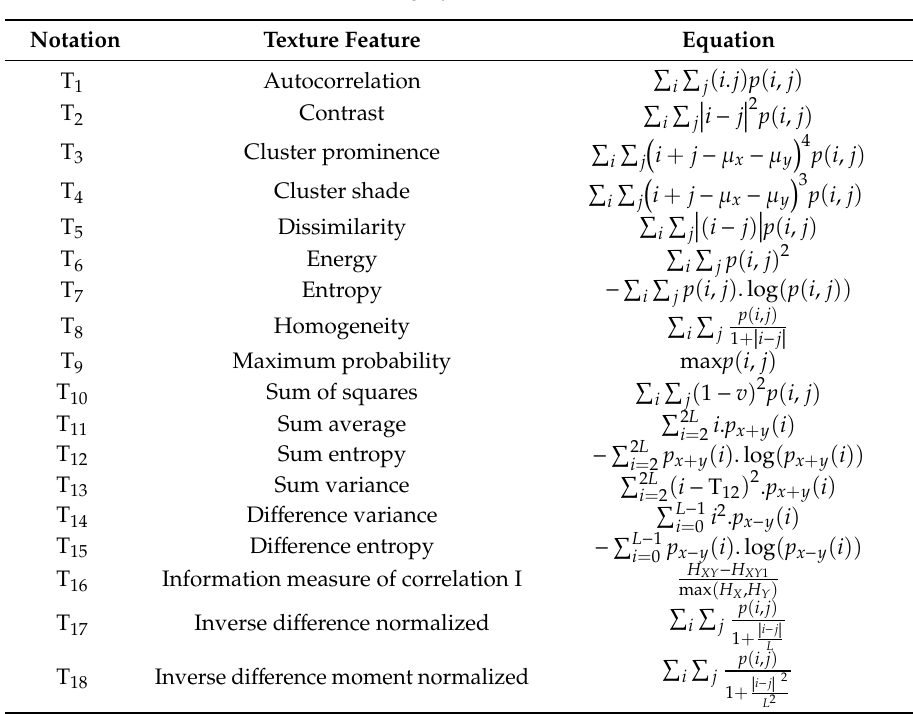
Table 1. Textural features from the gray level co-occurrence matrix (GLCM)